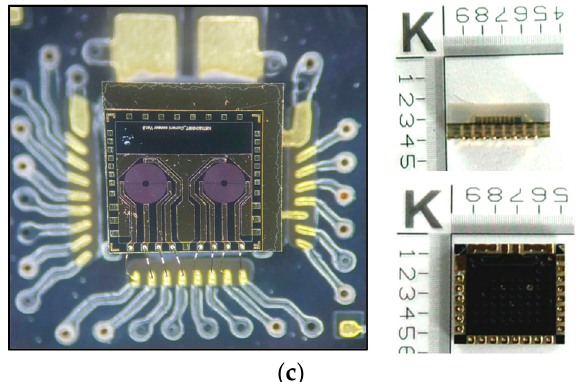
Figure 7. ( a ) The multi-chip structure of the current sensor, ( b ) the post-CMOS process procedure, and ( c ) a photograph of the fabricated current sensor.